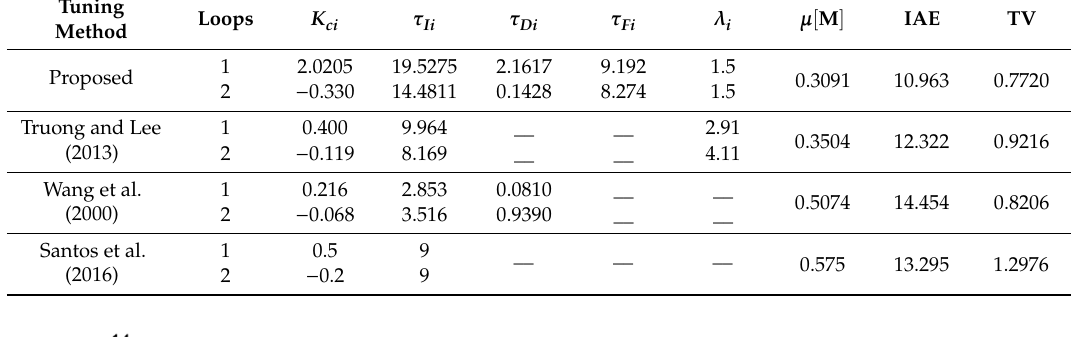
Table 4. Controller parameters and resulting performance indices for the WB column.